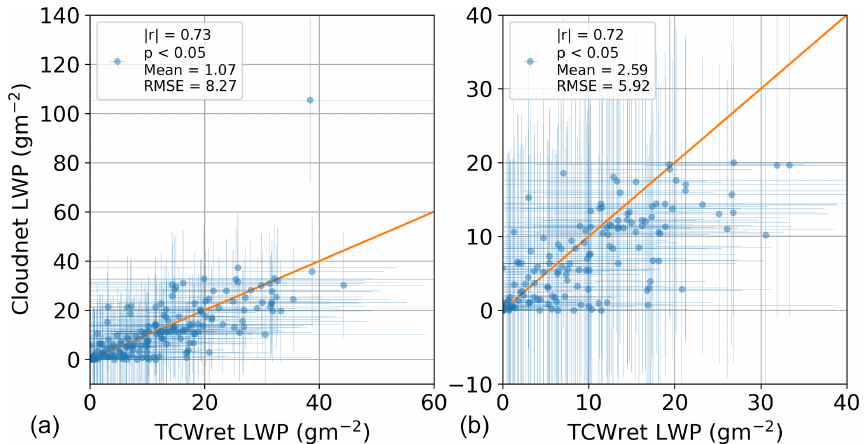
Figure 11. Liquid water path of TCWret versus Cloudnet for PWV < 1cm. Left scatterplot (a) contains all measurements, whereas the right plot (b) only shows clouds with LWP < 20gm − 2 .